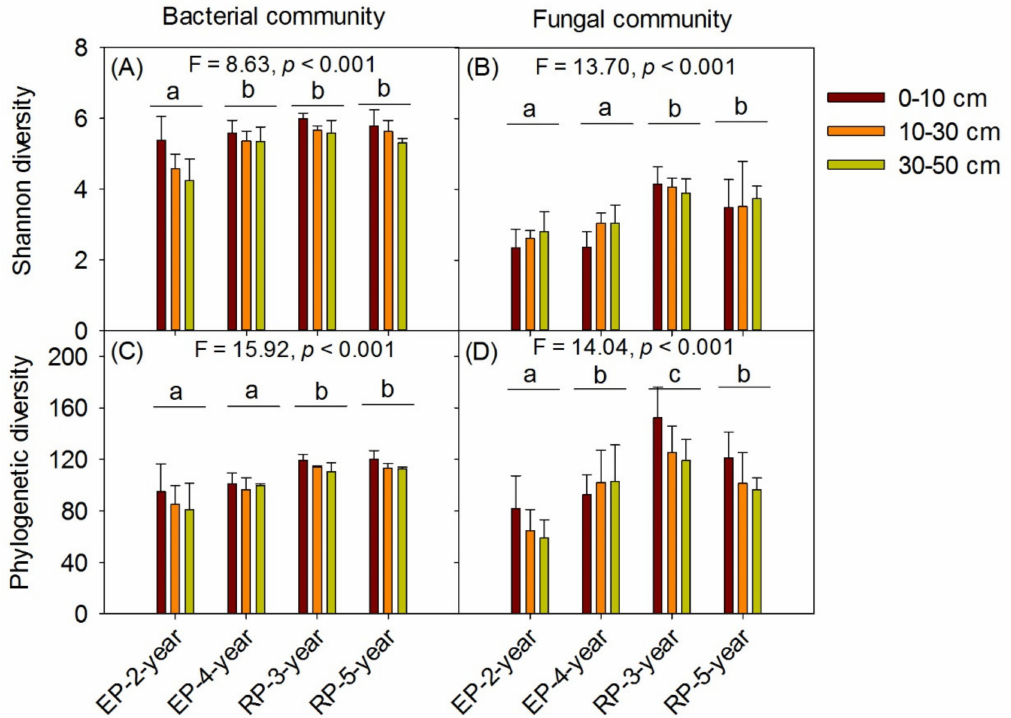
Figure 2. The α -diversity of soil bacterial and fungal communities along three soil depth (0–10 cm, 10–30 cm, 30–50 cm) under 2-year-old and 4-year-old Eucalypt plantations (EP-2-year and EP-4-year) and 3-year-old and 5-year-old Rubber plantations (RP-3-year and RP-5-year). AB, the taxonomic diversity indicated by Shannon Wiener index. CD, the phylogenetic diversity indicated by Faith’s Phylogenetic α -Diversity index. Lowercase letters above the grouped bars indicate the di ff erences among the four plantations. F-statistic and p values (df = 8) represent the overall di ff erence of the four plantations based on one-way ANOVA